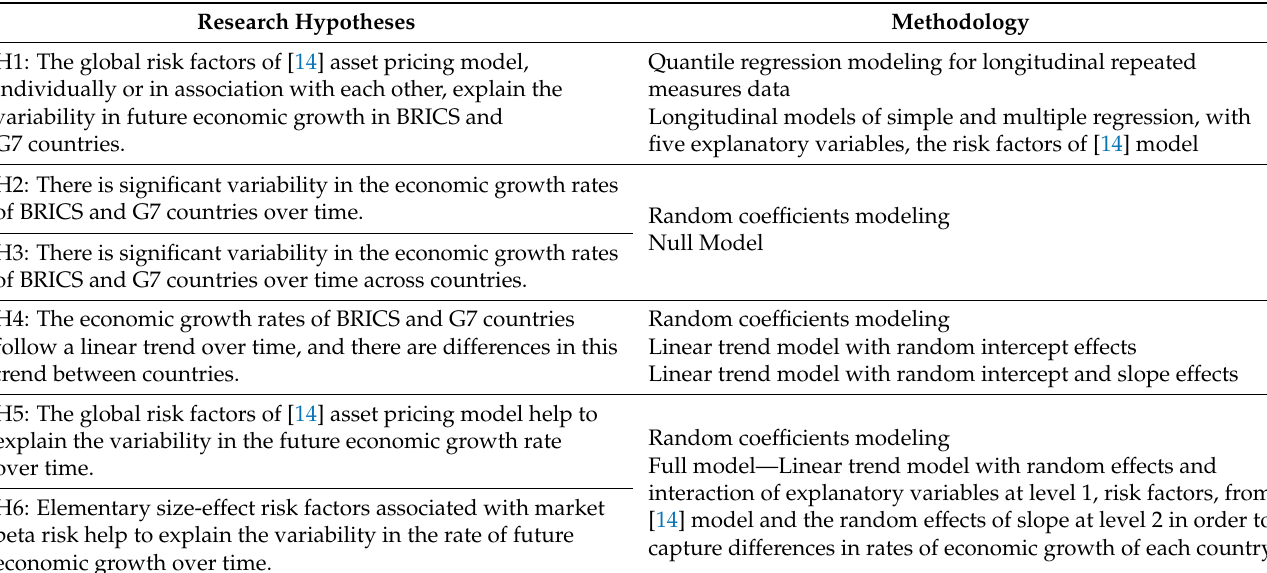
Table 1. Research hypotheses and methodologies for their